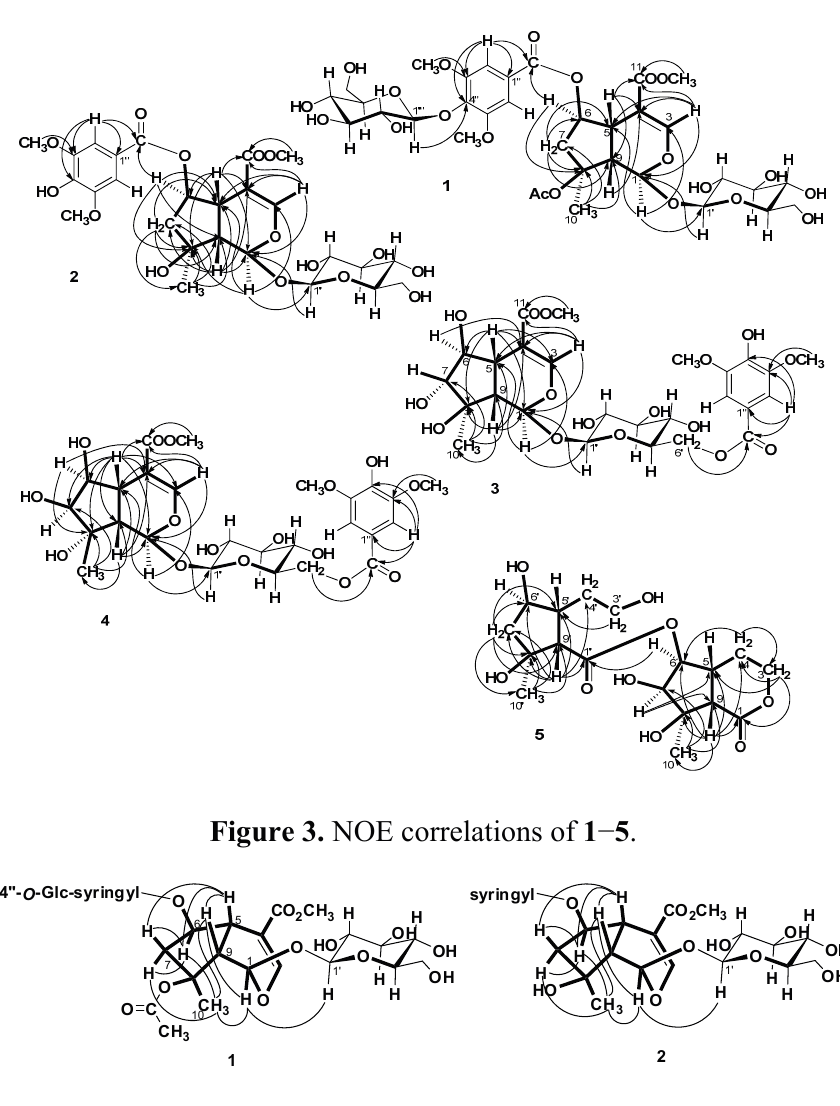
Figure 2. HMBC correlations of 1 − 5 .